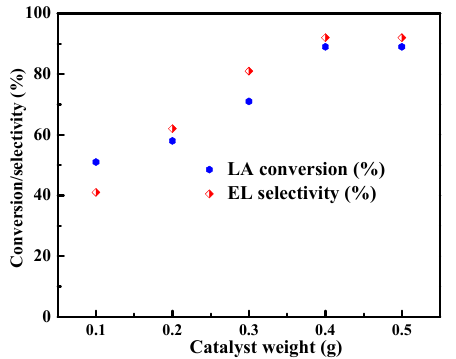
Figure 7. Effect of Pt/STA-ZrO 2 catalyst weight on esterification of LA with ethanol.